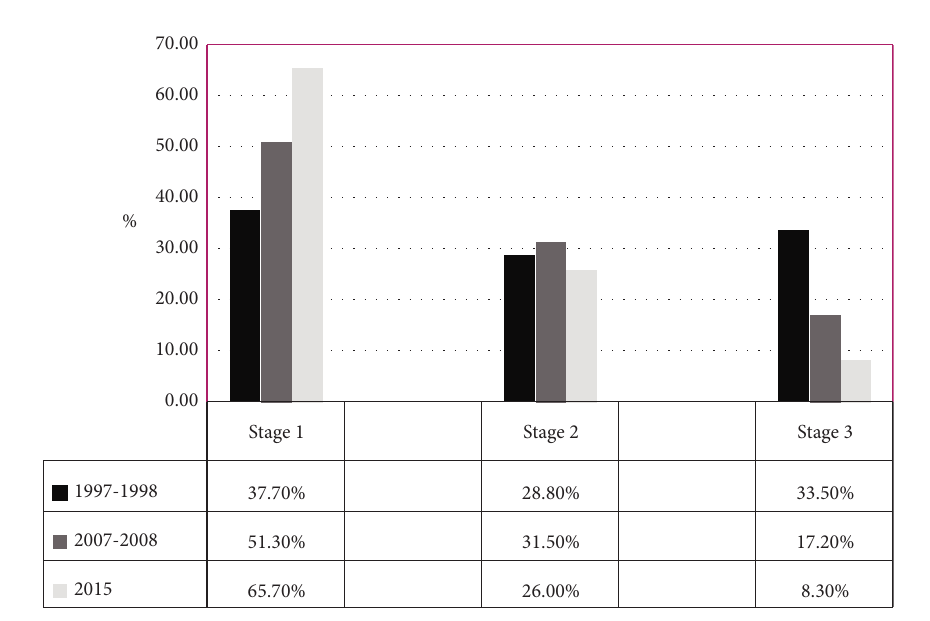
Figure 2: Changes in percentage of hypertension stages in 1997-2015.